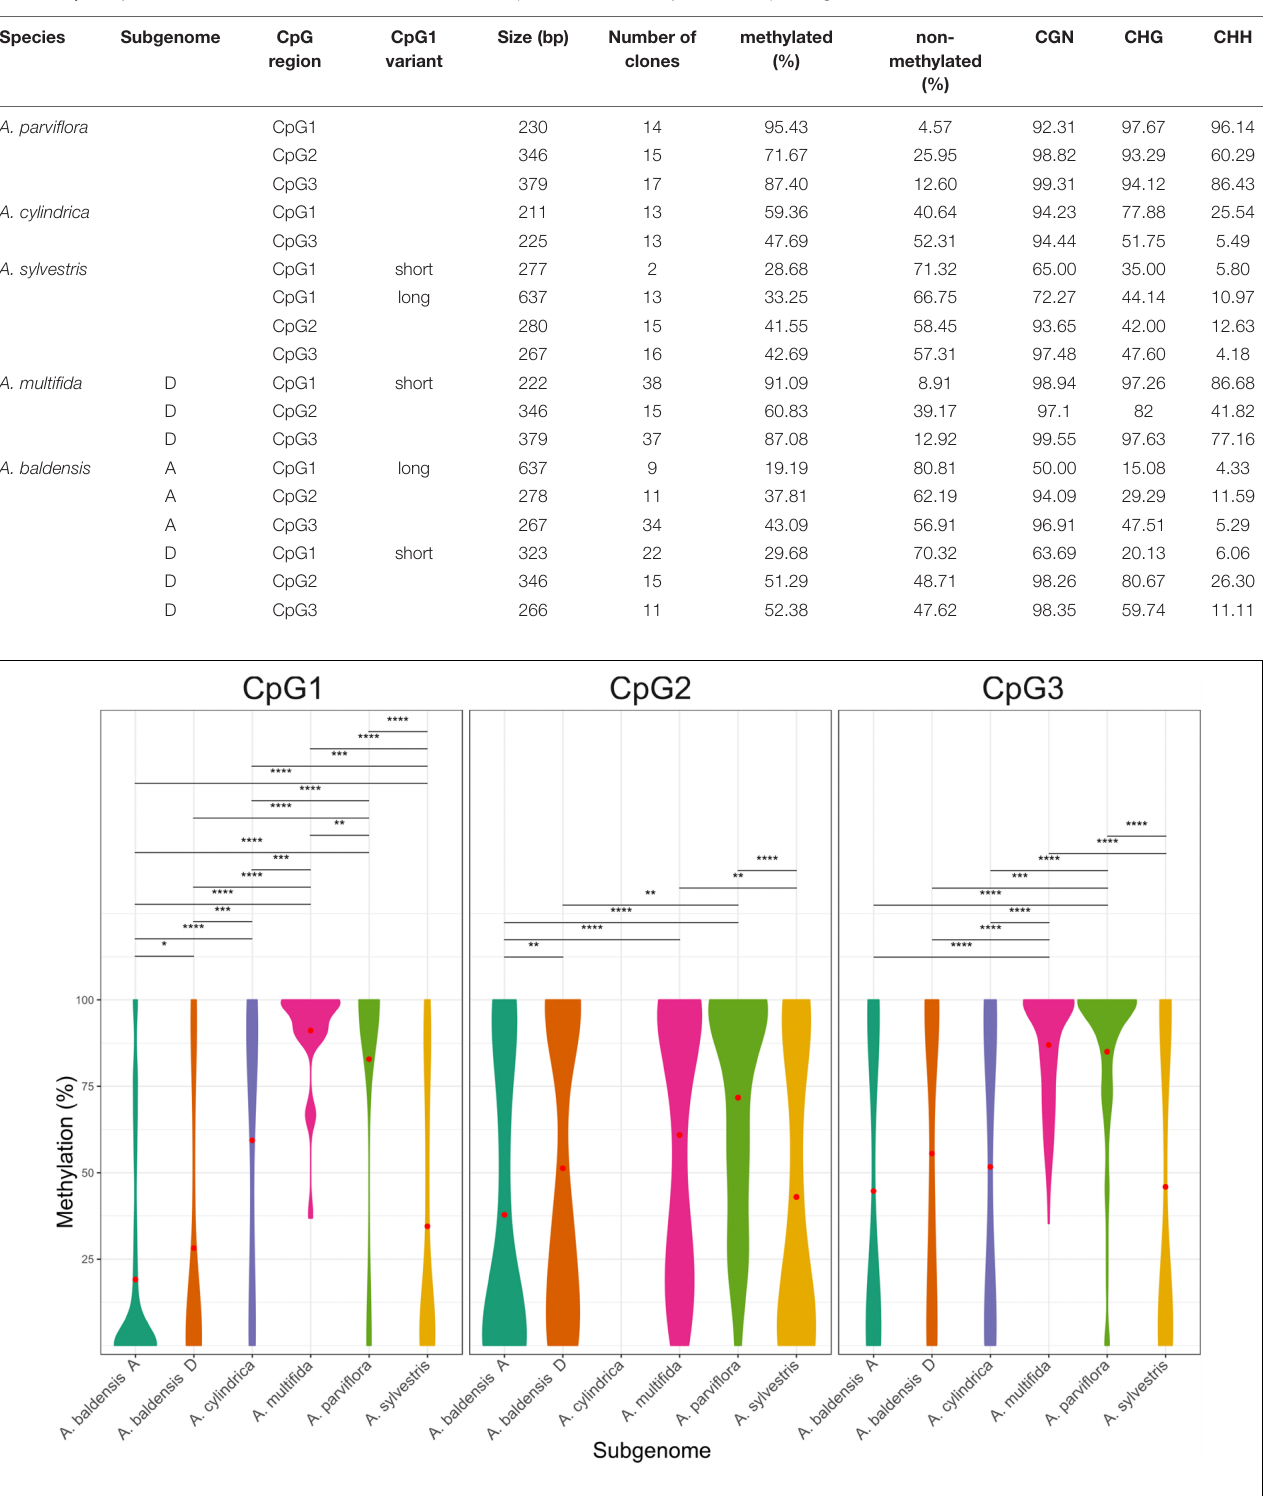
TABLE 4 | Methylation levels in the ETS of the 35S rDNA in studied species determined by bisulfite sequencing. Species